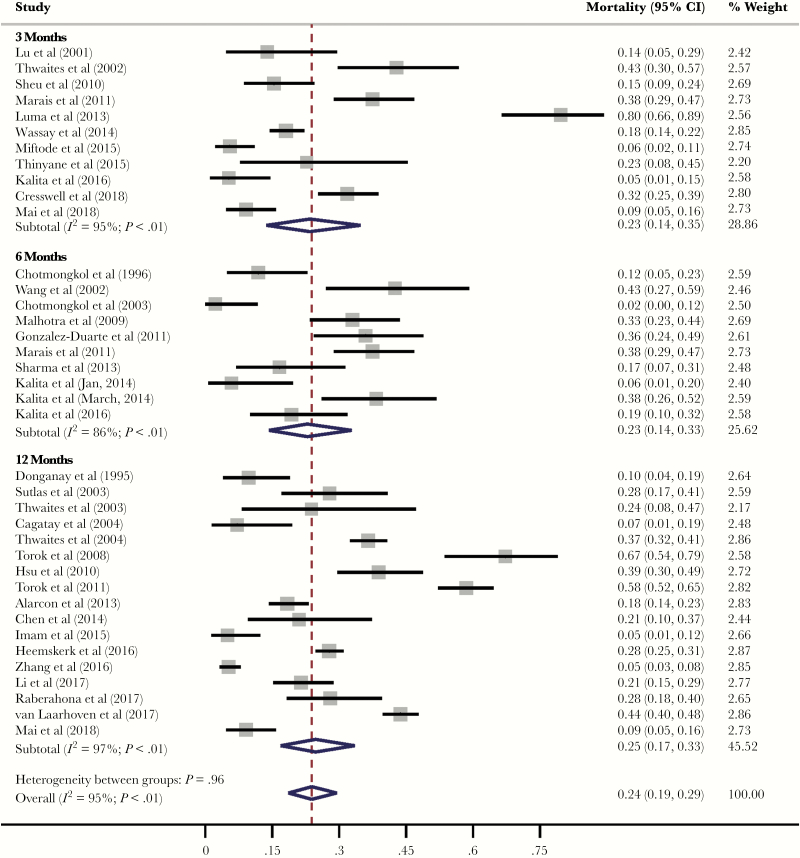
Tuberculous meningitis mortality by outcome reporting time point. Forest plots depicting mortality due to tuberculous meningitis at 3, 6, and 12 months. One study was excluded because the outcome time point was not reported.